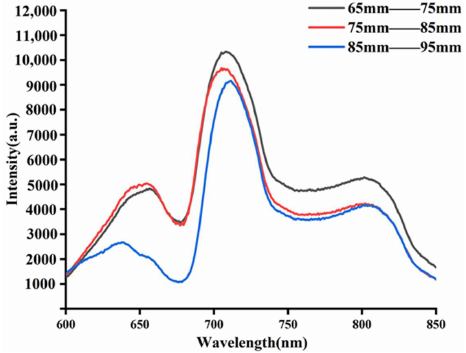
Figure 5. Apple spectra after size correction.